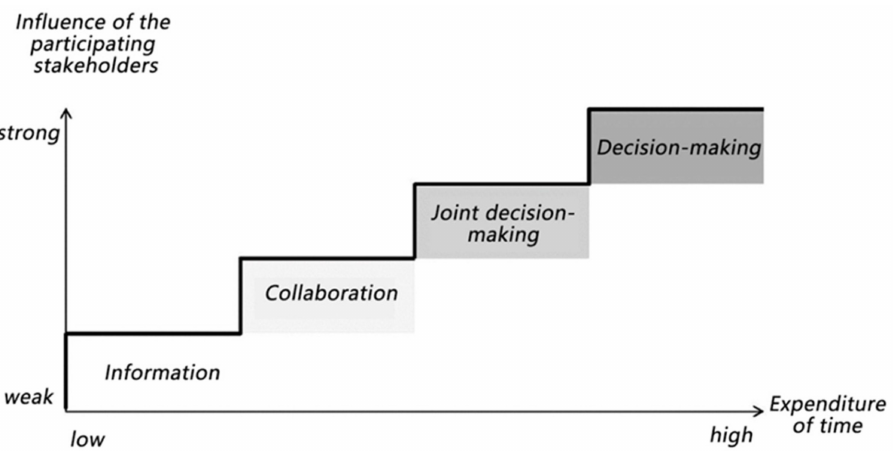
Figure 1. Multi-level model of